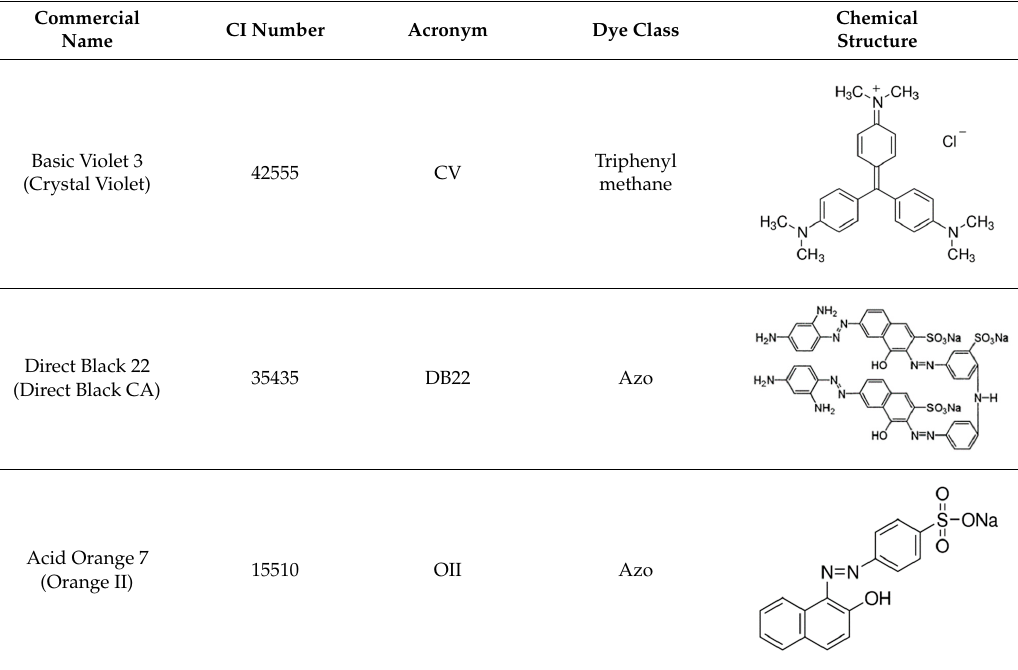
Table 1. Dyes used in the experiment, their commercial and color index (CI) number, acronym, class and chemical structure.